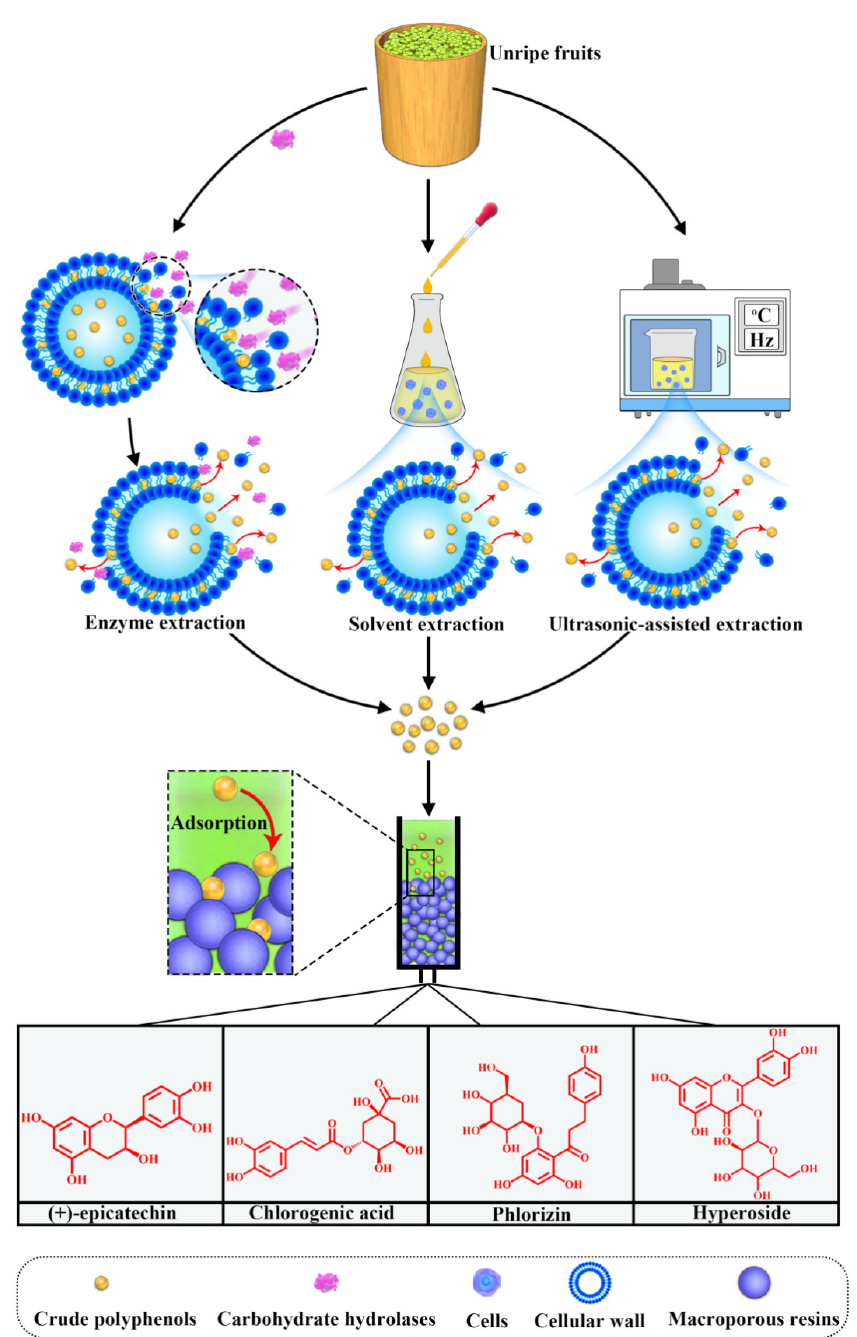
Figure 4. The methods of extracting Figure 5. The methods of extracting polyphenol. Shojaee-Aliabadi et al. [129] extracted polyphenols from unripe grapes using a